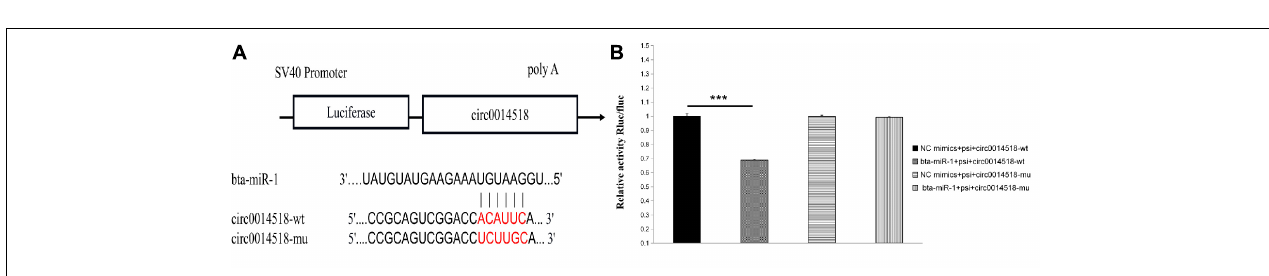
FIGURE 9 | The prediction and verification binding site of circ0014518 and bta-miR-1. (A) The predicted binding site of between circ0014518 and bta-miR-1. (B) Verification binding site of circ0014518 and bta-miR-1 the luciferase reporter assay. *** P < 0.01.